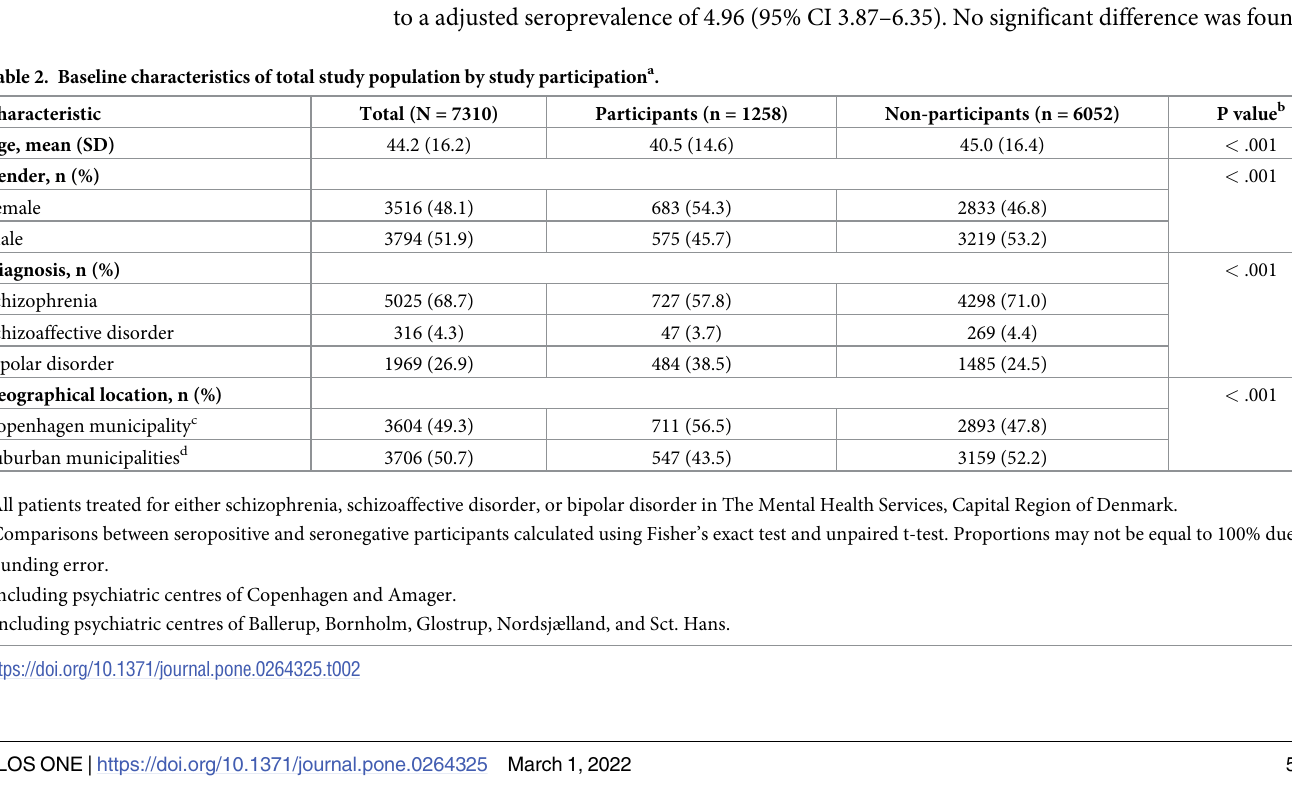
Most of the included patients (57.8%) were diagnosed with schizophrenia. Baseline character- istics of the included patients are presented in Table 1. Participants were significantly younger (mean age (SD): 40.5 (14.6) vs. 45.0 (16.4); p < .001) and more participants were females (54.3% vs. 46.8%; p < .001) and diagnosed with bipolar disorder (38.5% vs. 24.5%; p < .001) compared with SMI patients who did not participate in the study (Table 2).